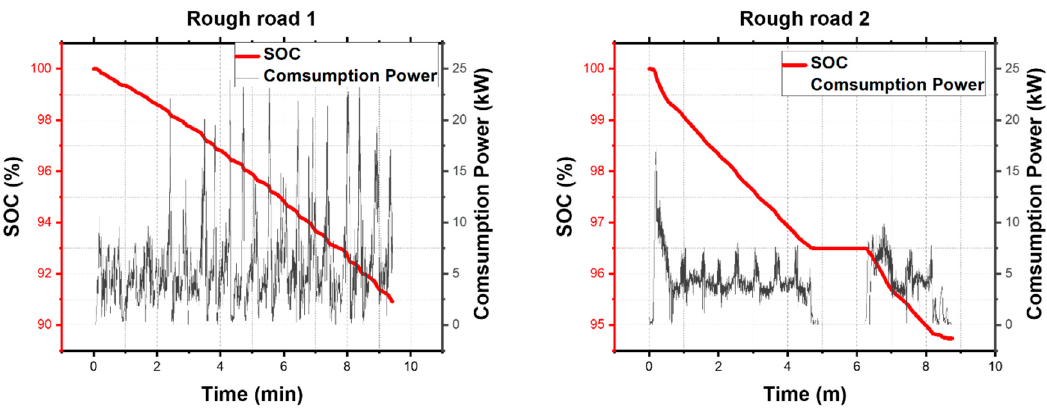
Figure 11. Power consumption trend during rough road driving.